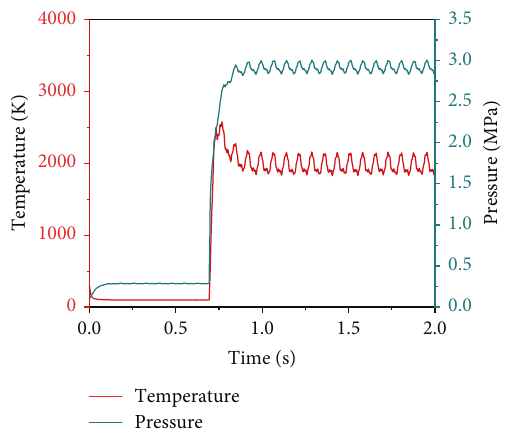
Figure 12: The start-up process of the pretest condition.